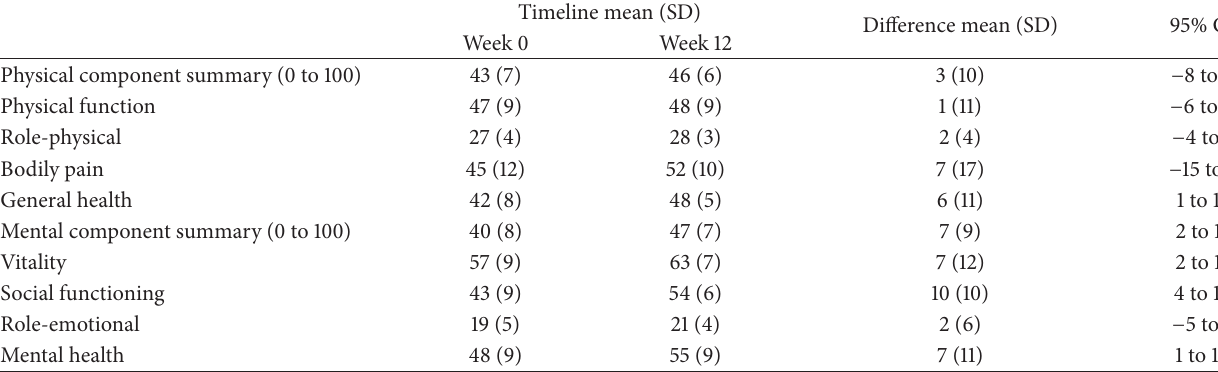
Table 2: Influence of a medium-impact exercise program on health-related quality of life